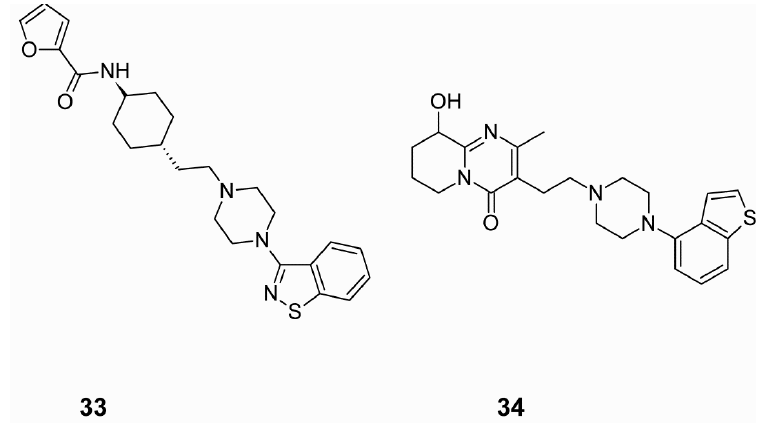
Figure 17. Potential multi-target antipsychotics with low probability of adverse effects.